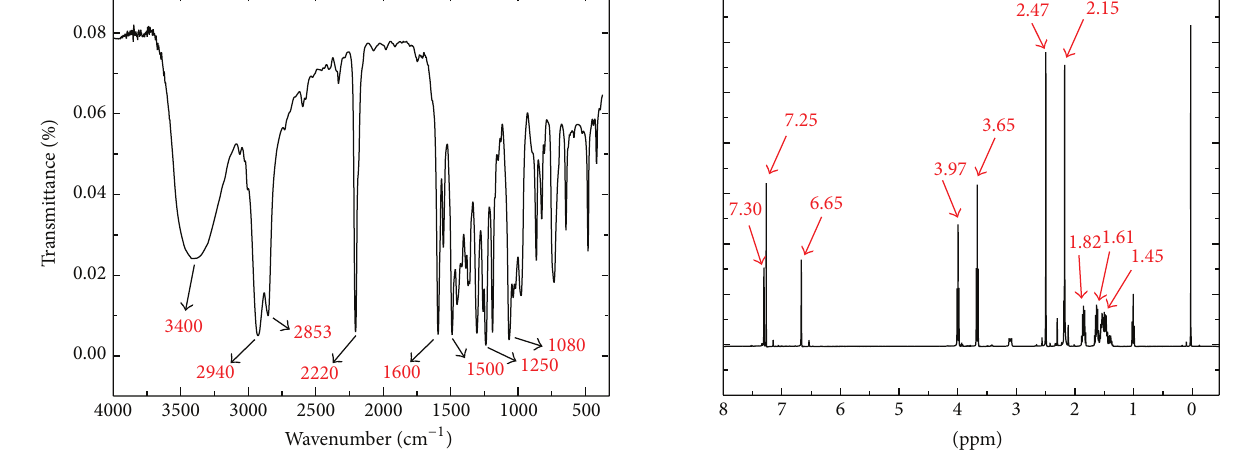
Figure 5: FTIR spectrum of 4-[(6-hydroxyhexyl)oxy]-2,5-dimeth- ylbenzonitrile.